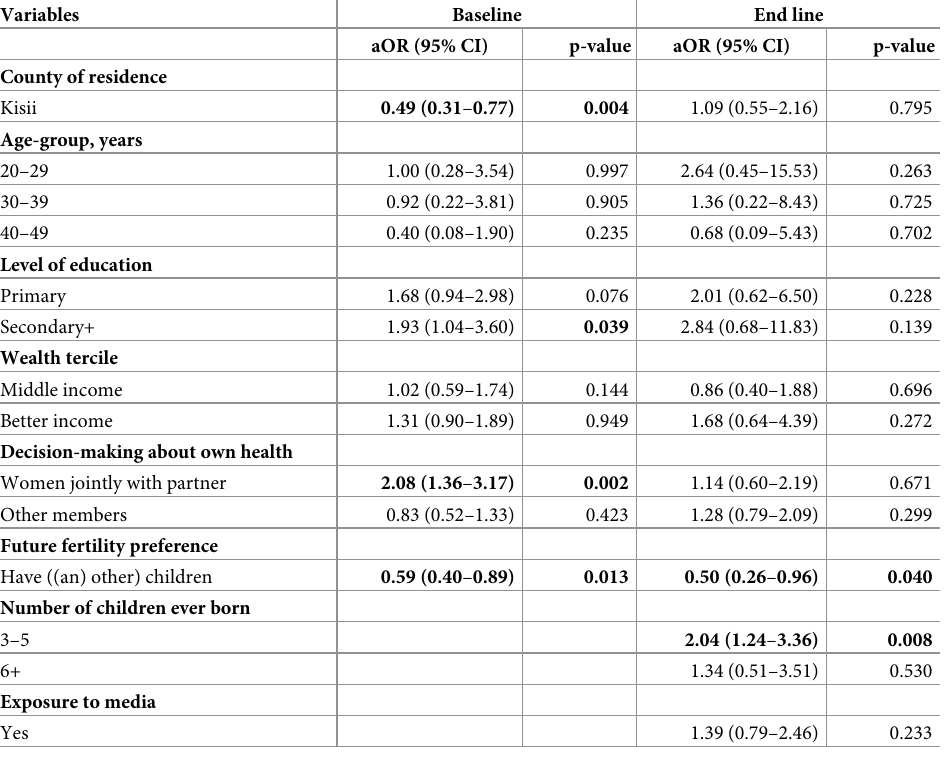
aOR: adjusted odds ratio; CI: confidence interval; cOR: crude odds ratio; FP: family planning; IQR: